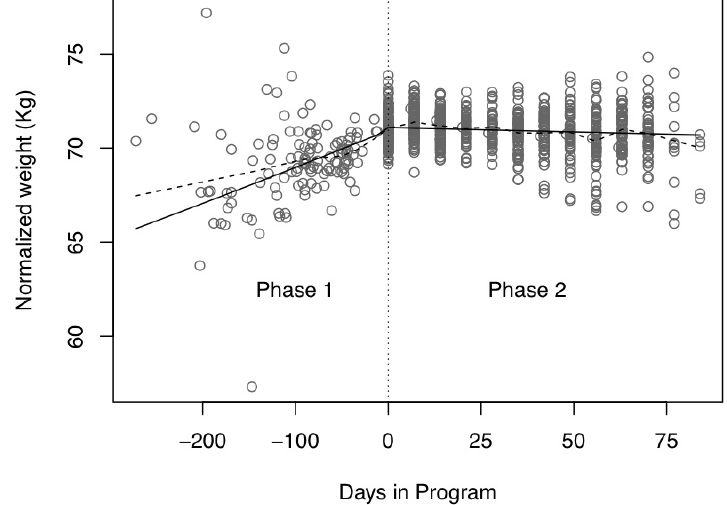
Figure 3 . Weight Trajectory from Intake to Baseline (Phase 1) and to Program Completion (Phase 2). Baseline Visit= Day zero; = Non-parametric smooth of the data points; = Overall prediction line from the mixed model effect; Normalized weight = log(weight); Phase 1: Intake to program baseline; Phase 2: Baseline to program